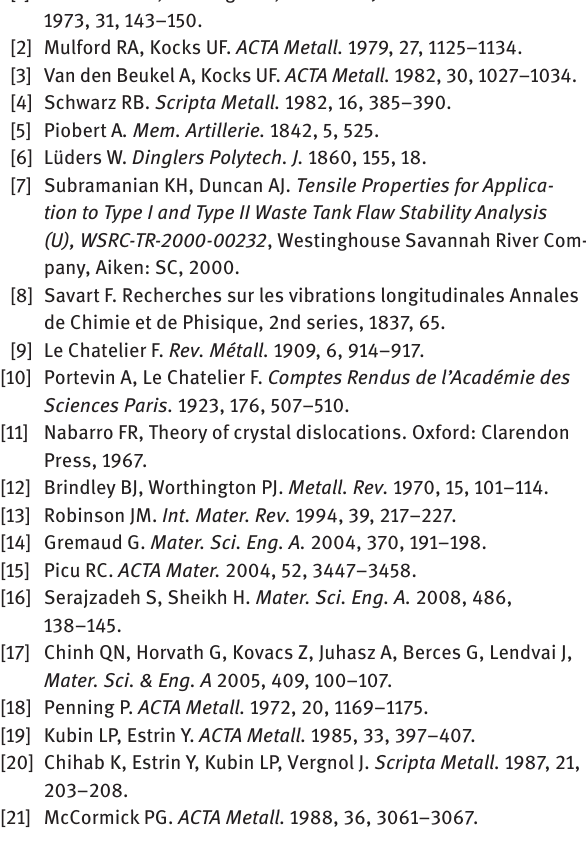
Figure 8: The PLC band properties in a Cu-Al alloy. (A) Space-time 1 2 -6 obtained from the model. plot of band propagation for E s ε = (cid:31) - 2 (B) Experimental space-time plot of band propagation